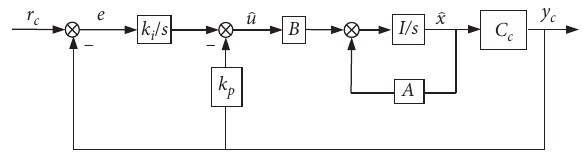
Figure 6: Schematic diagram of the RSLQR control.